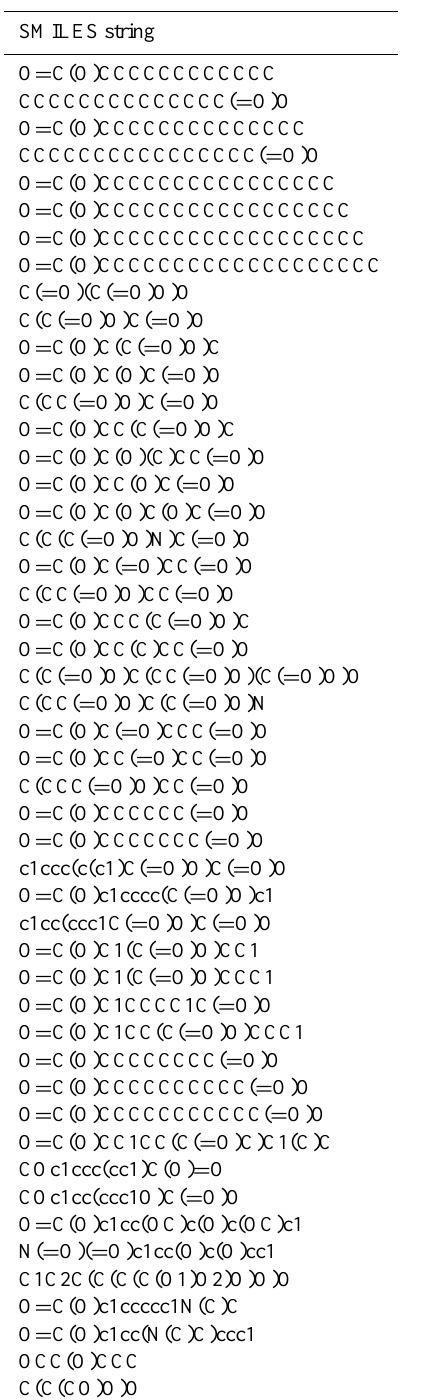
Table A3. In Sect. 3.2, 90 compounds used in an equimolar mix- ture for calculating mixed inorganic–organic growth factors. Once again, to replicate those results, copy and paste these SMILES, with equal molar concentrations, into a text file and follow the procedure covered in the main body of